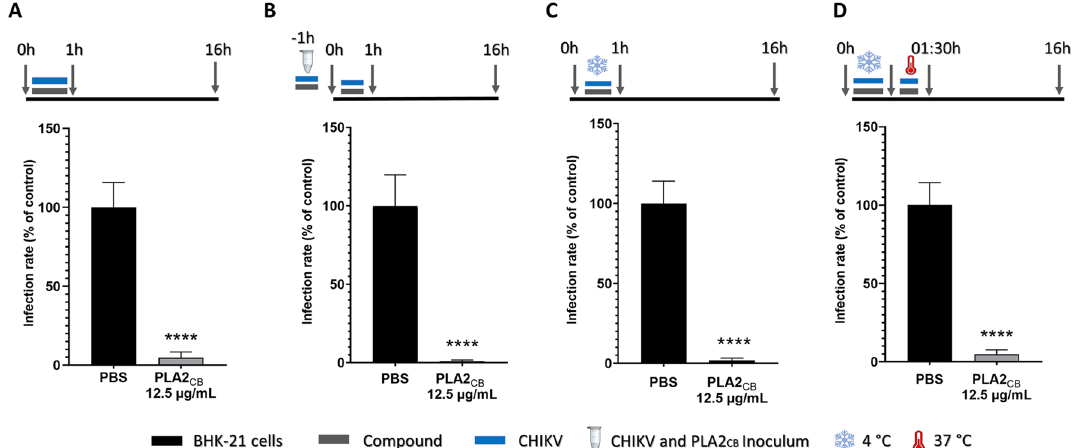
Figure 3. PLA2 CB has virucidal activity and blocks CHIKV entry to the host cells. ( A ) BHK-21 cells were infected with CHIKV- nanoluc (MOI 0.1) and simultaneously treated with PLA2 CB at 12.5 μg/mL for 1 h. Cells were washed and replaced by fresh medium. ( B ) CHIKV- nanoluc and PLA2 CB at 12.5 μg/mL were incubated for 1 h at 37 °C and then for one extra hour with the cells. Then, virus and compound were removed, cells were washed with PBS, and added fresh medium. ( C ) BHK-21 cells were infected with the virus and simultaneously treated with PLA2 CB at 12.5 μg/mL for 1 h at 4 °C. The cells were washed to remove virus and compound and replaced with fresh medium. ( D ) BHK-21 cells were infected with virus and simultaneously treated with PLA2 CB at 12.5 μg/mL for 1 h at 4 °C. Then, cells were incubated for additional 30 min with compound and virus at 37 °C, washed with PBS and replaced by fresh medium. For all assays, CHIKV replication was measured by nanoluc activity at 16 h.p.i.. Schematic representation of each time-based assay as indicated by BHK-21 cells (black bars), PLA2 CB (grey bars), and CHIKV- nanoluc (blue bars), CHIKV and PLA2 CB inoculum (microtube), incubation at 4 °C (ice crystal) and incubation at 37 °C (thermometer). Mean values ± SD of a minimum of three independent experiments each measured in triplicate. (****) P < 0.0001. All images were generated using GraphPad Prism 8 and GIMP 2.10.20 (www. gimp. (Fig. 4A). To reveal the effect of PLA2 CB on virus RNA replication in the absence of production and spread of virions, BHK-CHIKV-NCT cells were used. This stable cell line contains CHIKV replicon which continuously expresses viral nonstructural proteins and two reporters: Renilla luciferase from nonstructural region and EGFP via activity of viral subgenomic promoter. Measurement of activities of these reporters allows the evaluation of the effect of PLA2 CB on replication complexes formed during the replication stage as well as on production and translation of subgenomic RNAs. Treatment of BHK-CHIKV-NCT cells with PLA2 CB at 12.5 µg/mL for 72 h after treatment revealed the reduction of Renilla luciferase expression by 58% without causing detectable cytotoxicity (Fig. 4B); this data confirms observation made using CHIKV- nanoluc . Furthermore, the levels in EGFP expression were also reduced as seen in Fig. 4C, indicating decrease of subgenomic RNA synthesis and/ or translation. Taken together, these results suggest that PLA2 CB inhibits post-entry stages of infection possibly interfering with functioning of CHIKV nonstructural proteins.